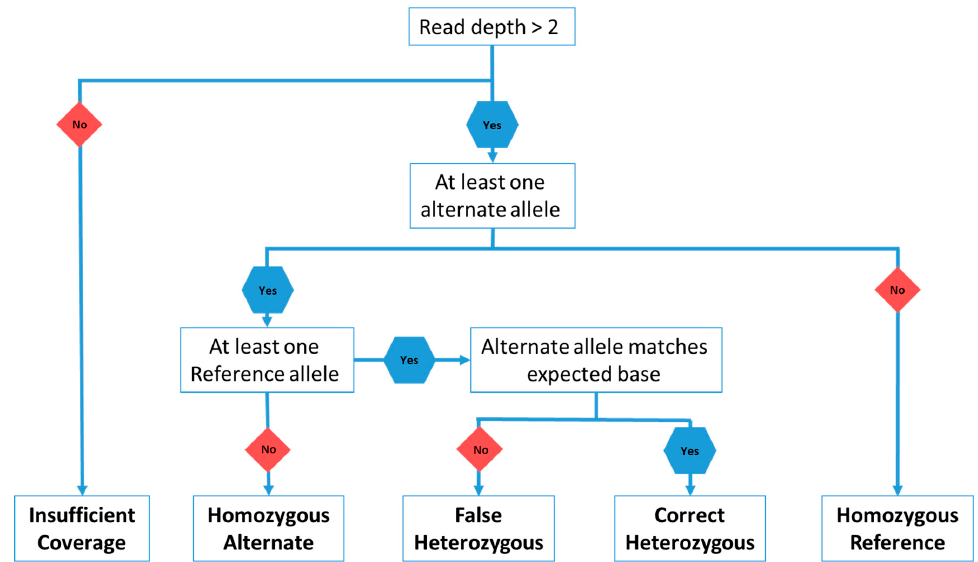
Figure 4. Flow chart for the genotype calling script that was used with the VCF files generated by Samtools and BCFtools.